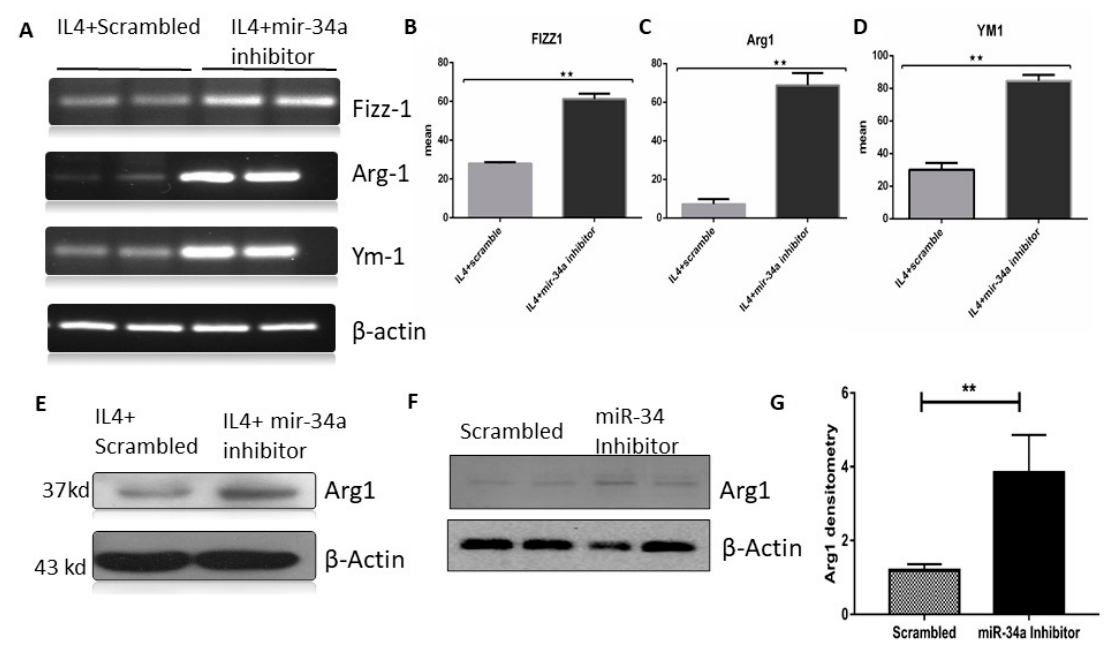
Figure 5. miR-34a inhibition promoted M2 phenotype and inhibited M1 markers. RAW264.7 cells were transfected with miR-34a scrambled or inhibitor or mimic and treated with IL-4 for 16 hrs. ( A ) RT-PCR was performed for M2 phenotype marker genes Klf4 , Arg-1 , Fizz-1, and Ym1. ( B–D ) Gel bands were quantified by densitometry and normalized by actin. ( E–G ) Immunoblot of Arg1 in scrambled and miR-34a inhibitor-treated groups with or without IL-4. Statistical difference between the groups analyzed by t-Test. ** p < 0.01 ( n = 4).